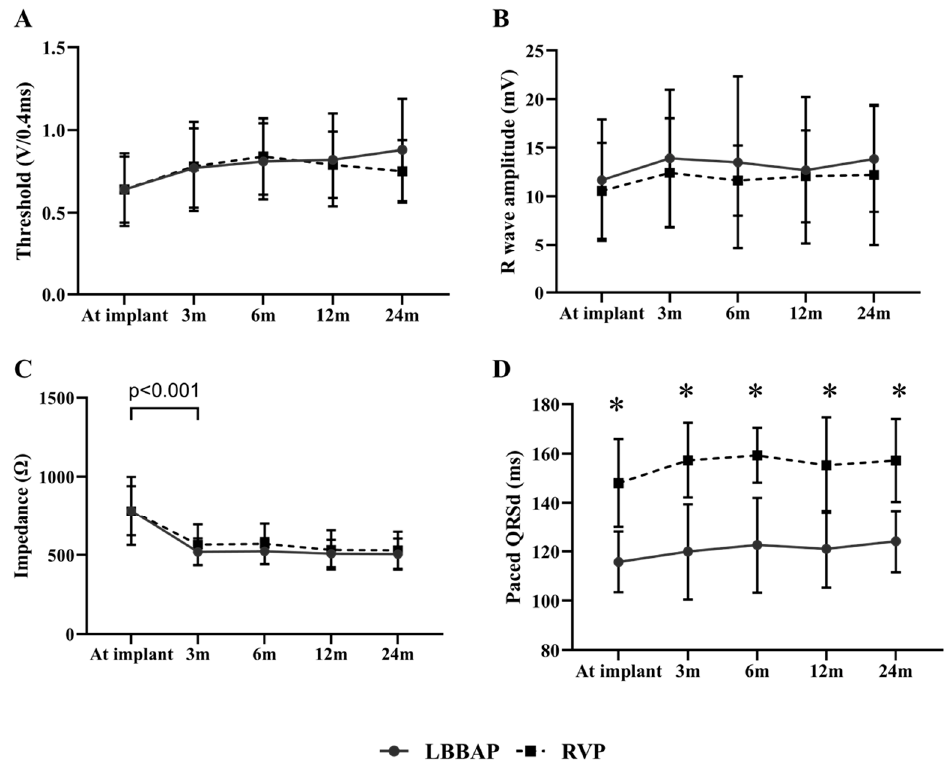
Figure 1. Comparison of pacing parameters between LBBAP and RVP at baseline and during follow-up. ( A , B ) LBBAP (solid line) produced stable capture thresholds and R wave sensing amplitudes comparable to RVP (dashed line) at baseline and during follow-up; ( C ) Both groups demonstrated a significantly decreased pacing impedance three months post-implant ( p < 0.001) and then remained stable during follow-up; ( D ) LBBAP presented with a narrowed paced QRS duration than RVP did. The difference in QRS duration persisted between two groups during follow-up ( p < 0.001); LBBAP = left bundle branch area pacing; RVP = right ventricular pacing.